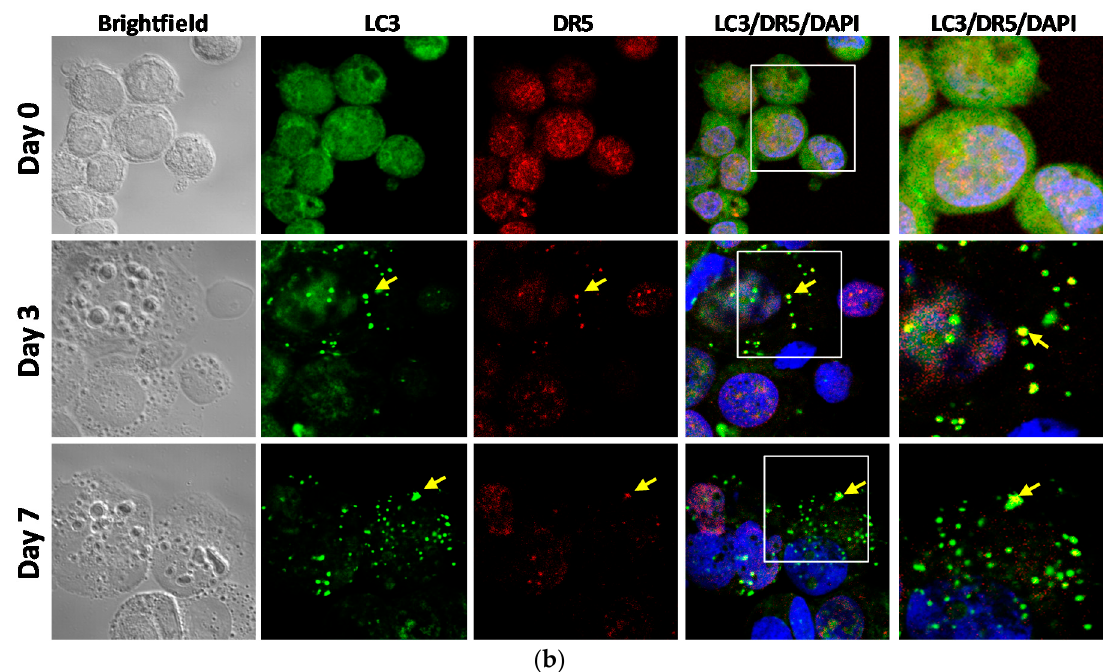
Figure 4. DR5 localized to autophagosome for degradation under suspension culture. ( a ) Representative images of the MDA-MB-231, ZR75-1 and MCF7 cells, cultured in monolayer (Day 0) or suspension for three or seven days, captured using imaging flow cytometry. Figure shows brightfield (BF), LC3-AF488 (green), DR5-PE (red), and a composite image of the co-localization of the LC3 and the DR5 (yellow), with the associated bright detail similarity score, per cell (yellow number in the top right). (Single fluorophore controls are shown in Figure S4). Bivariate flow cytometry plots of the LC3-AF488 and the DR5-PE, with the associated DR5-PE histogram, per time-point. Population percentages are shown for the dual-positive population. Mean bright detail similarity scores of the breast cancer cells cultured in monolayer or suspension culture for three or seven days. Bright detail similarity (BDS) scores were calculated on the dual-positive populations only (mean ± SEM; n = 3; * p < 0.05, ** p < 0.01 relative to monolayer). ( b ) Immunocytochemistry and confocal microscopy of the cyto-spun ZR75-1 cells cultured in monolayer (day 0) or suspension for three or seven days. LC3 (AF488, green), DR5 (AF594, red), DAPI, brightfield, and composite micrographs are shown. Yellow arrows indicate co-localized LC3 and DR5. Images taken at 40×.